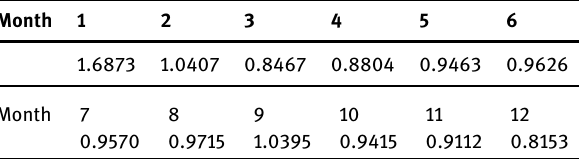
Table 2: Seasonal index of monthly cigarette sales